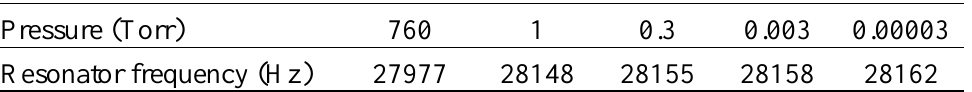
Table 1. Resonant frequency shift for Device K1 under different